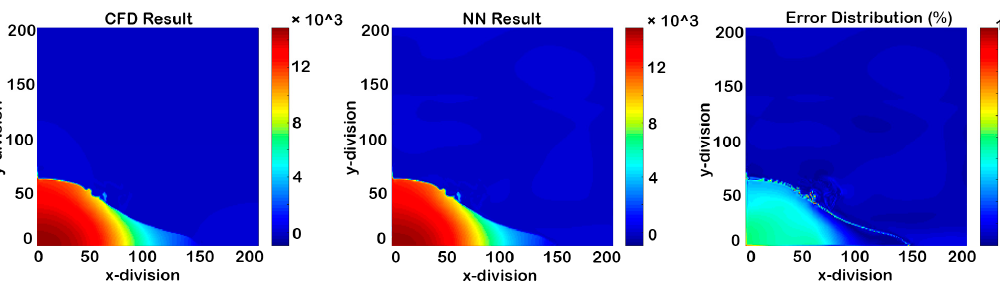
Figure 33. Cascading results of Model Ⅲ for pressure (14 time-steps after deployment).